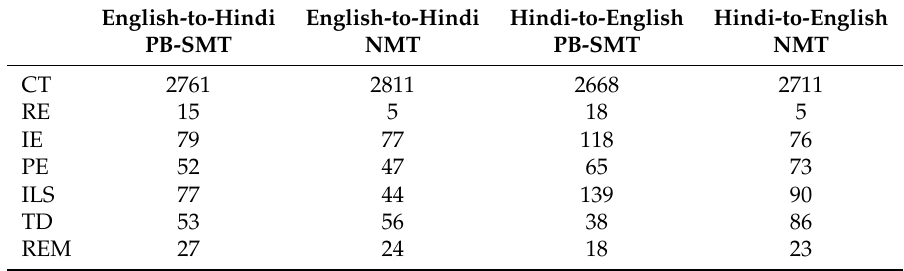
Table 4. Classification of terminology translations by the human evaluator in the English-to-Hindi and Hindi-to-English PB-SMT and NMT tasks; total number of terms: 3064. English-to-Hindi English-to-Hindi Hindi-to-English Hindi-to-English